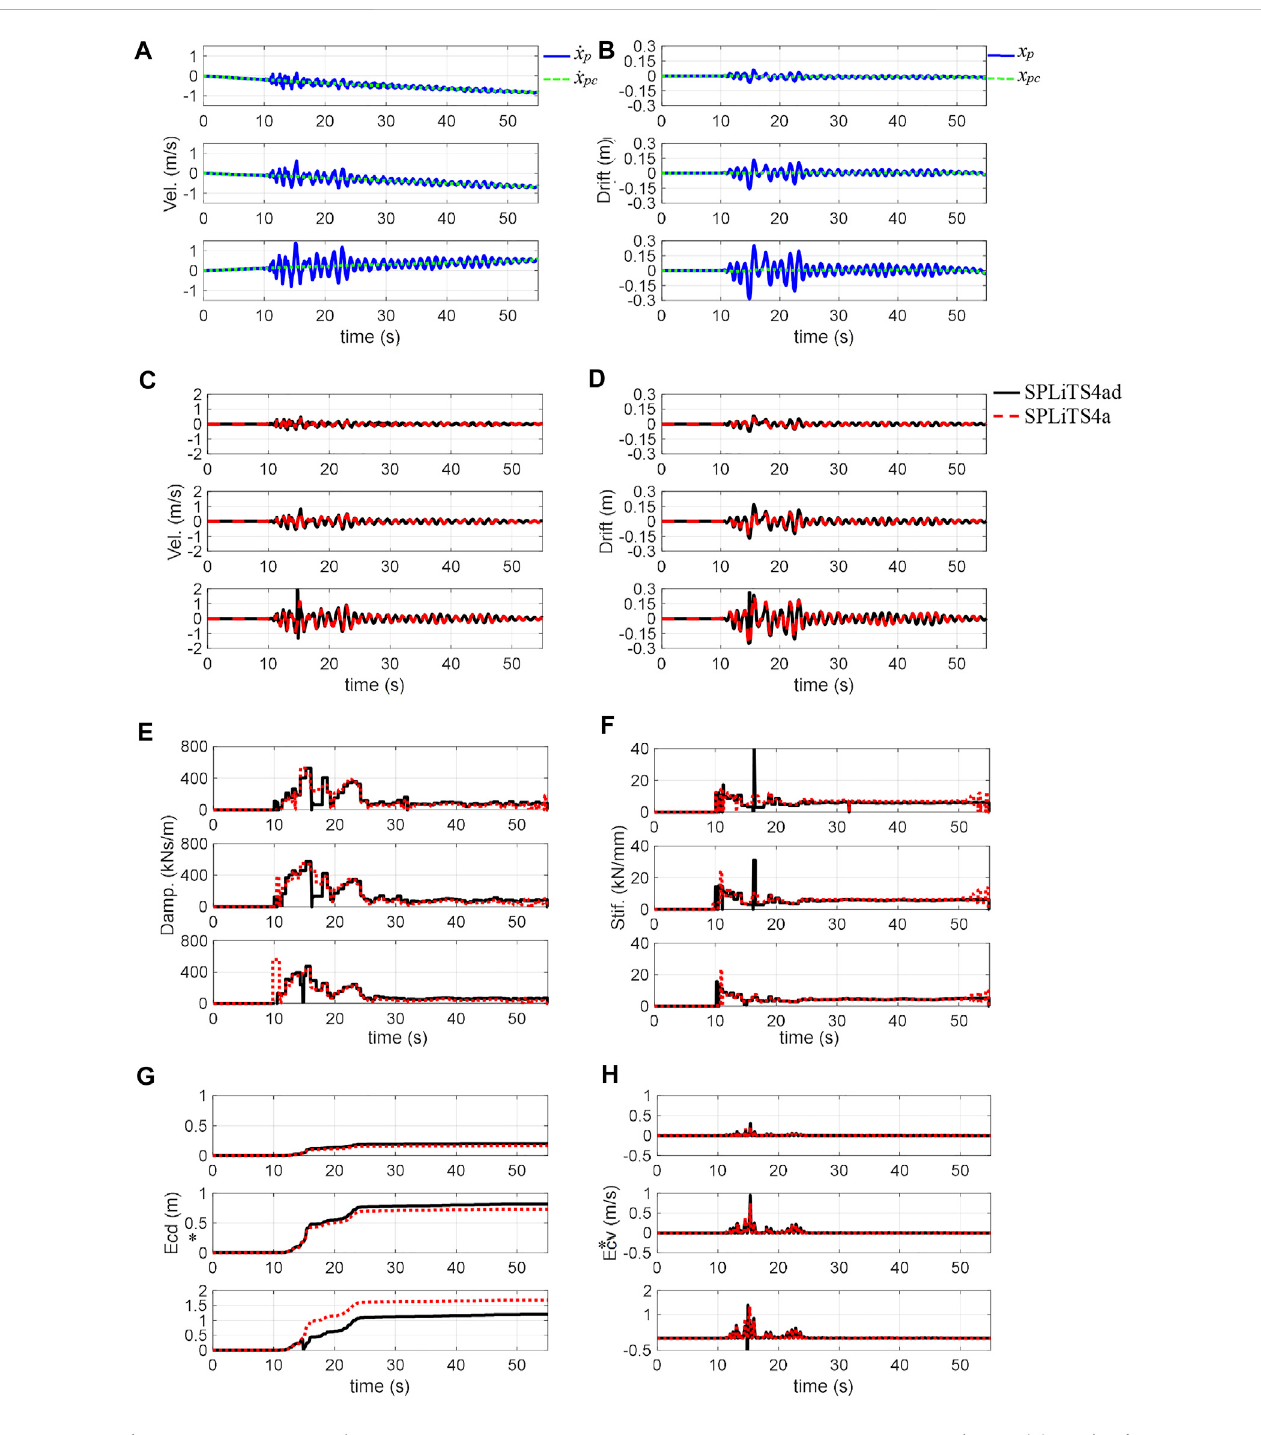
FIGURE 13 Structuralresponsesof100%TakatoriandestimatesbySPLiTS: (A) velocityobtainedbyintegration, (B) displacementobtainedbyintegration, (C) velocity with minimised central-point shift components, (D) displacement with minimised central-point shift components, (E) estimated damping, (F) estimated stiffness, (G) structural energy absorption E* cd , and (H) energy absorbing rate E* cv . N.B.: The top, middle and bottom in each fi gure corresponds to third, second, and fi rst storeys,